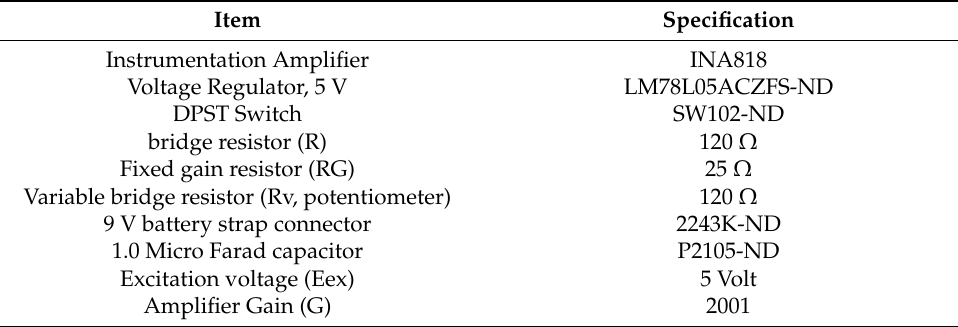
Figure 16. Implementation of the amplifier circuit: ( a ) Graphical description of the load cell circuit board; ( b ) Description of the actual amplifier circuit. Table 2. List of the parts for the amplifier